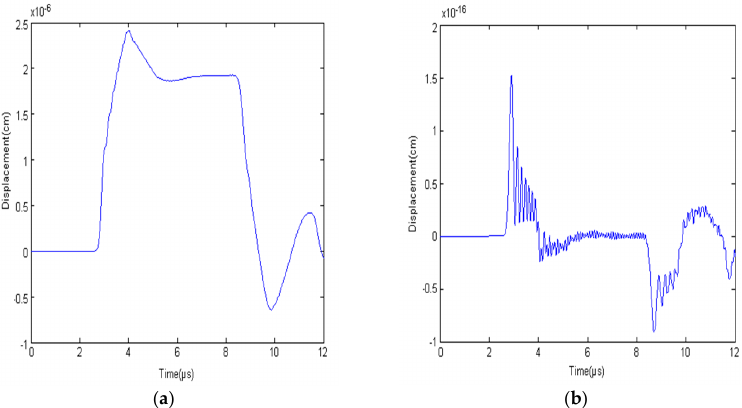
Figure 15. Normalized dynamic stress intensity factor versus time.